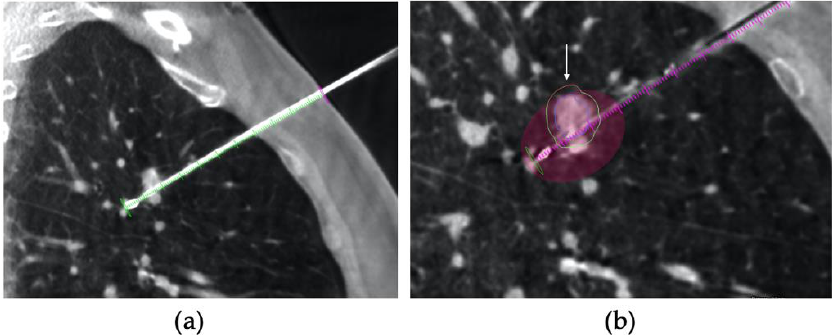
Figure 2. VPS was applied to CBCT images. ( a ) on sagittal CBCT scan, MWA is placed over the virtual one and ( b ) the predicted ablation volume is seen as a purple ellipsoid and the red line (white arrow) shows that the nodule is not completely encompassed in the predicted volume.